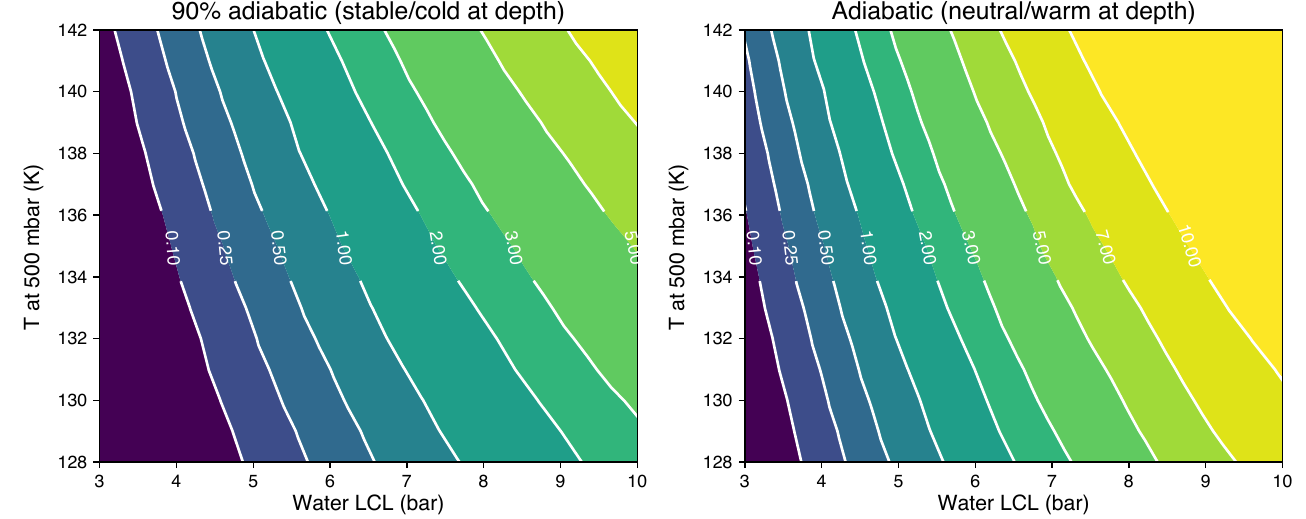
Figure 17. Contours of water abundance are shown as a function of lifting condensation level (LCL) on the x -axis and temperature at the 500-mbar level on the y -axis. Two panels give end member cases for temperature profile extrapolation below the 500-mbar level: a statically stable extrapolation on the left that gives colder temperatures at deep levels, and a neutrally stable extrapolation on the right that gives warmer temperatures at deep levels. Abundances are relative to the protosolar value of H 2 O/H 2 = 1.07 × 10 − 3 from